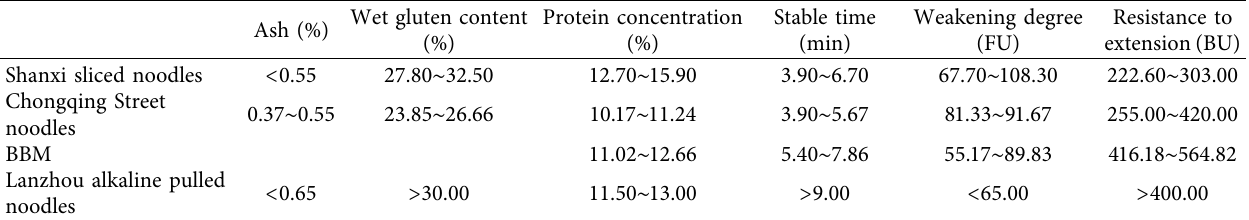
Table 7: Quality index of wheat flour for making different kinds of noodles.